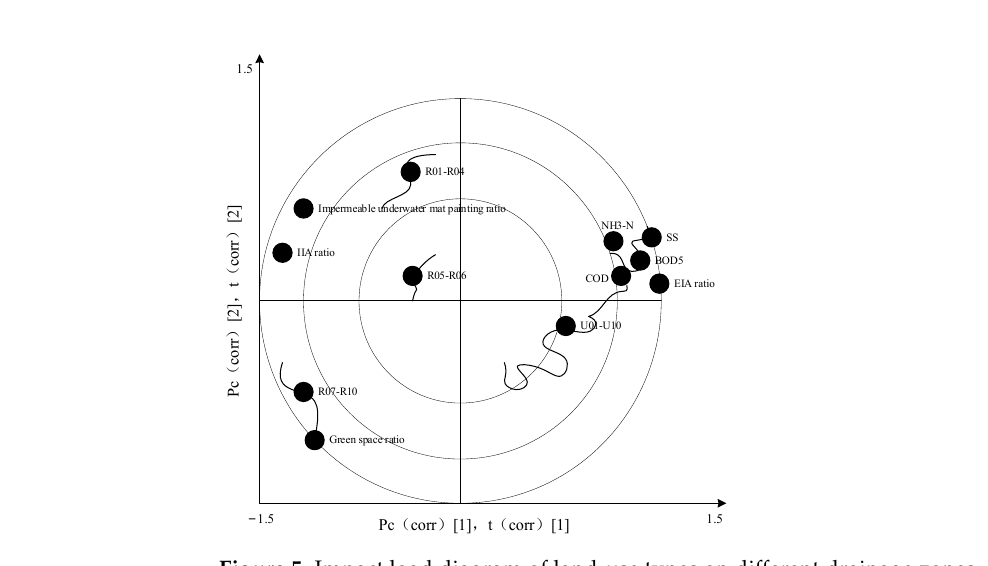
Figure 5. Impact load diagram of land-use types on different drainage zones. Some of the empirical equations for the ratio of water quality indexes to land-use indexes are calculated through PLS regression. These equations are greatly affected by soil types. The specific calculation is expressed as in Equation